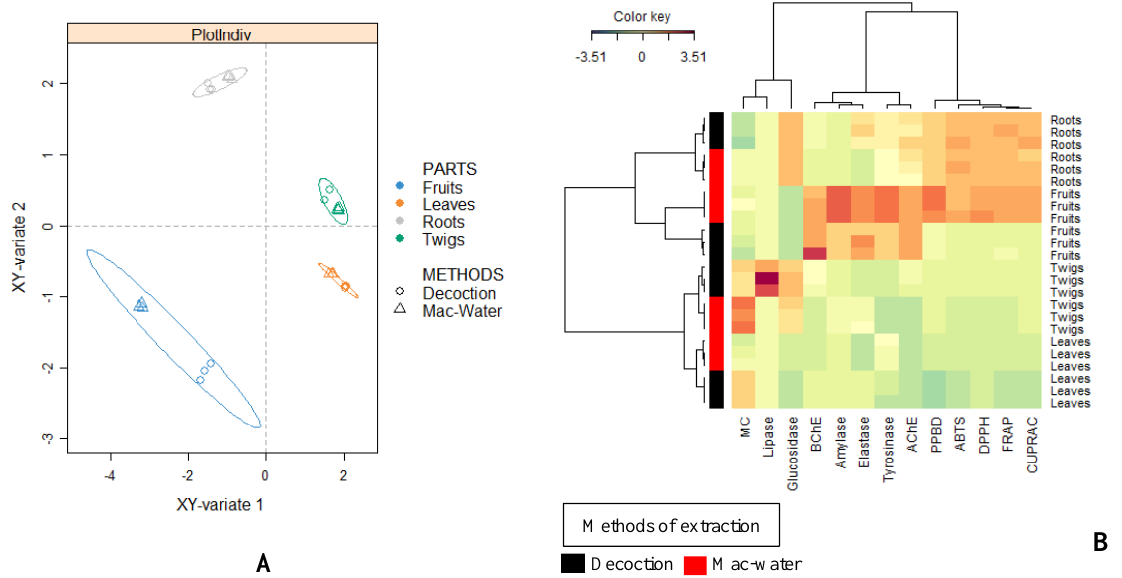
Figure 4. ( A ) Sparse PLS-DA score plot based on biological activities; ( B ) hierarchical cluster analysis (heatmap) based on biological activities.